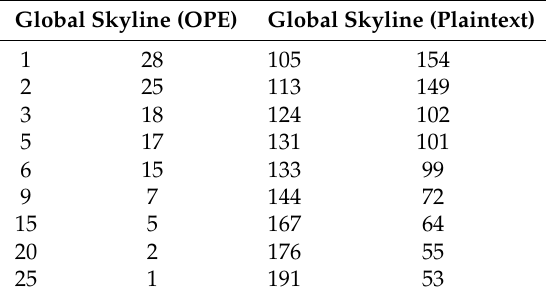
Table 3. Decrypted objects of the global